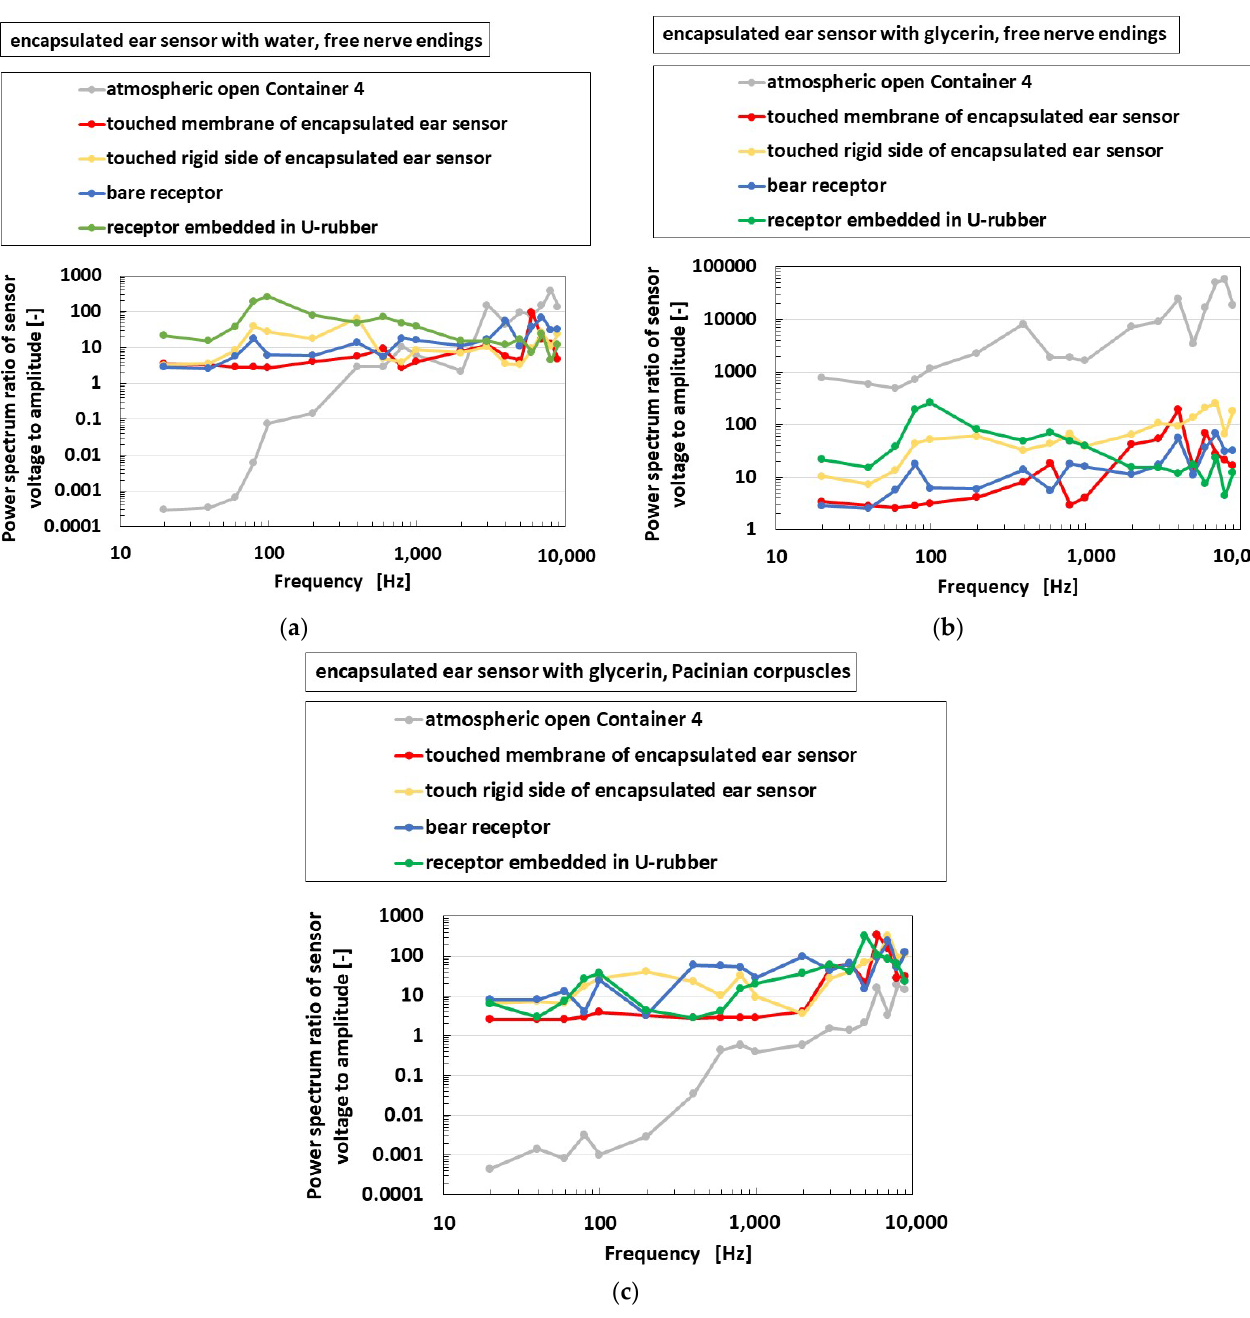
Figure 20. Experimental results of the vibrating auditory sensor with the vibration of a speaker when each receptor and sensor are compared: ( a ) with free nerve endings in water; ( b ) with free nerve endings in glycerin; ( c ) with Pacinian